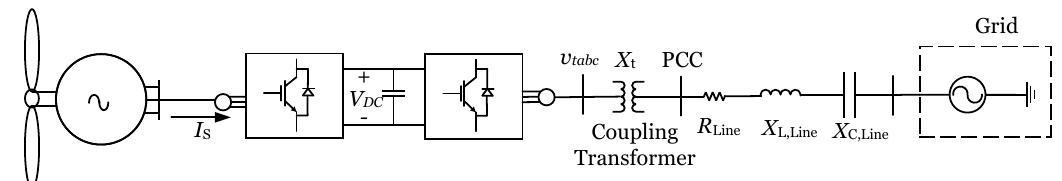
Figure 7. Schematic diagram of a Type IV wind